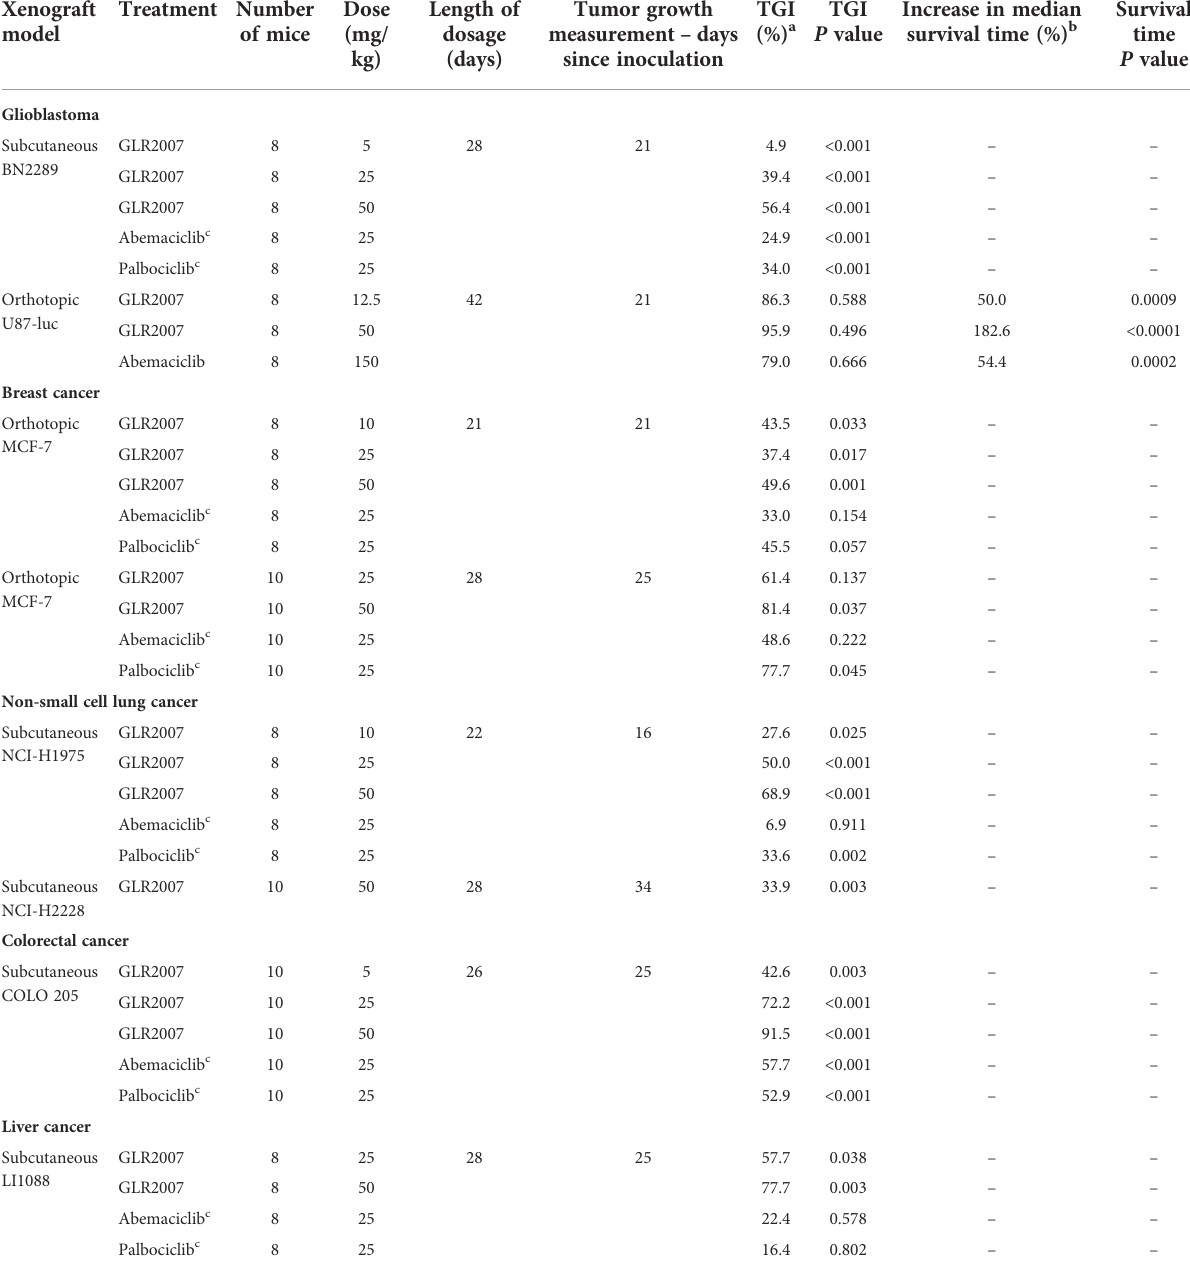
TABLE 1 Tumor growth inhibition and changes in median survival time in mouse xenograft models. Xenograft